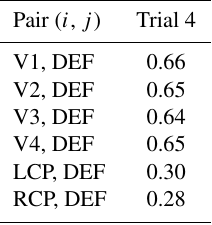
Table 9. Mean values of the power correlation coefficients over fre- quency for different antenna pairs.